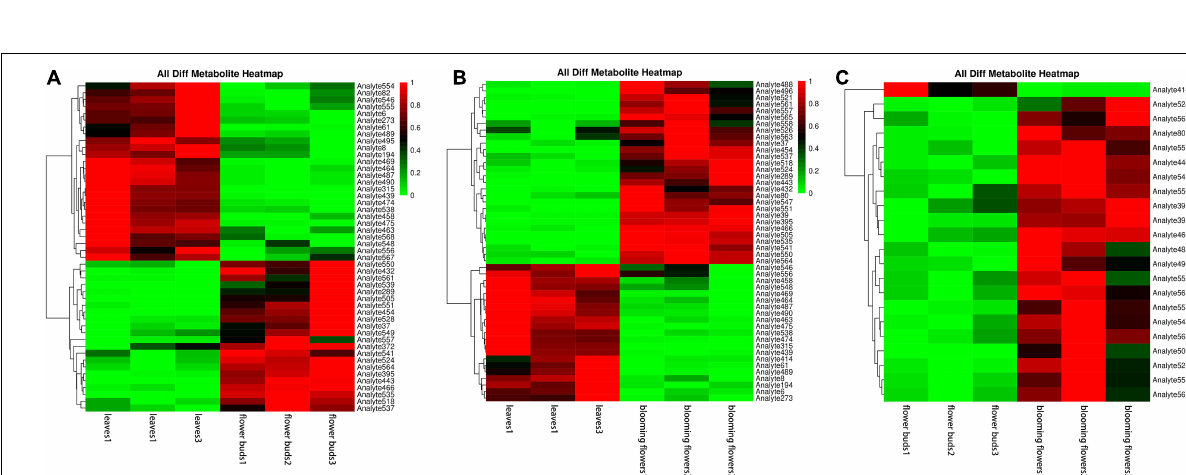
Frontiers in Genetics |